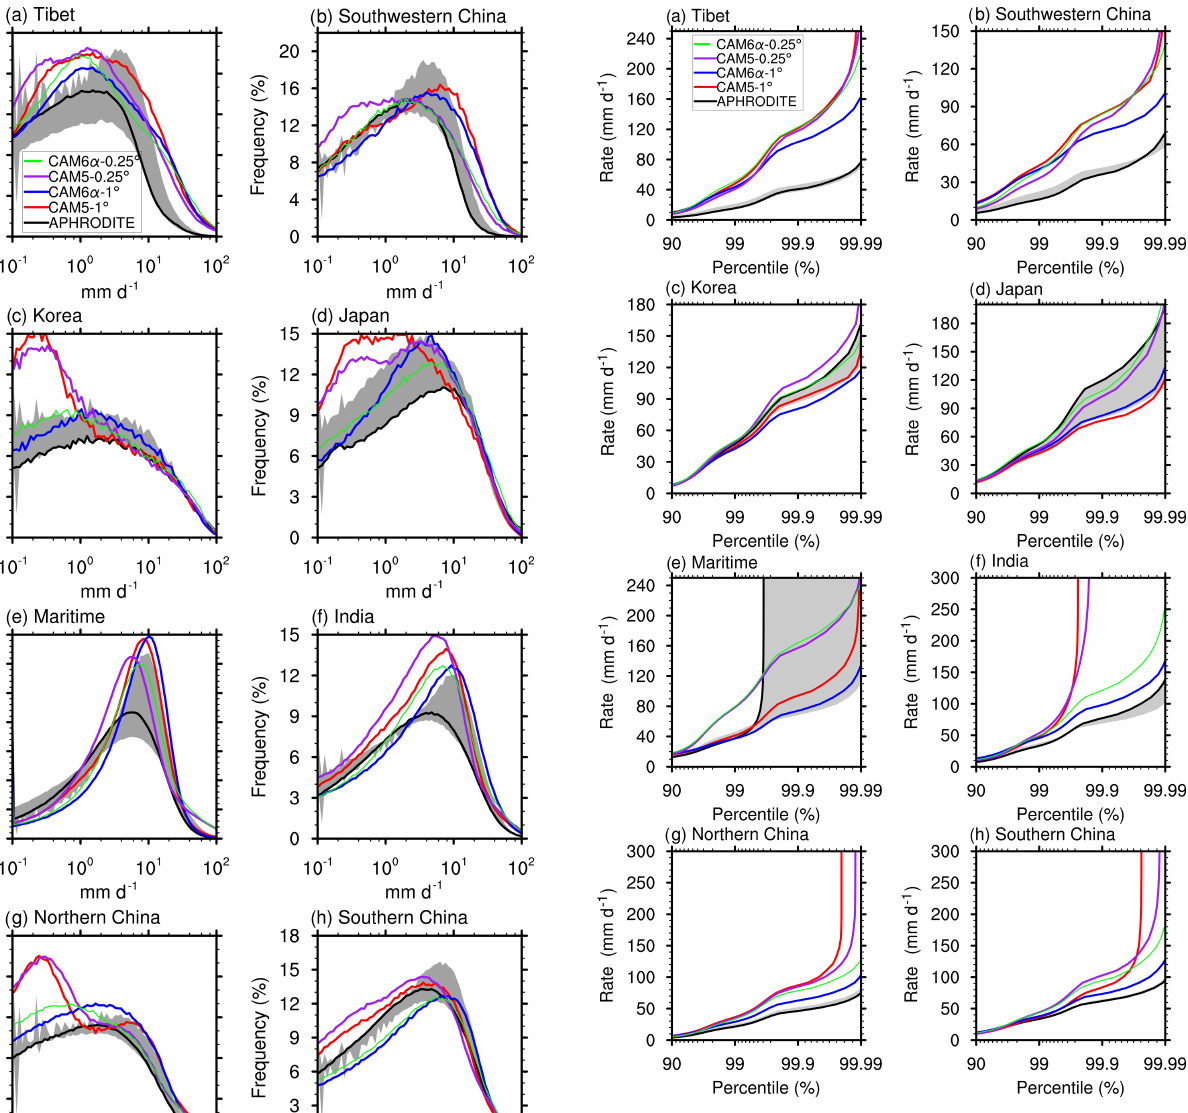
Figure 12. Similar to Fig. 11, but for daily precipitation rates (mmd − 1 ) as a function of